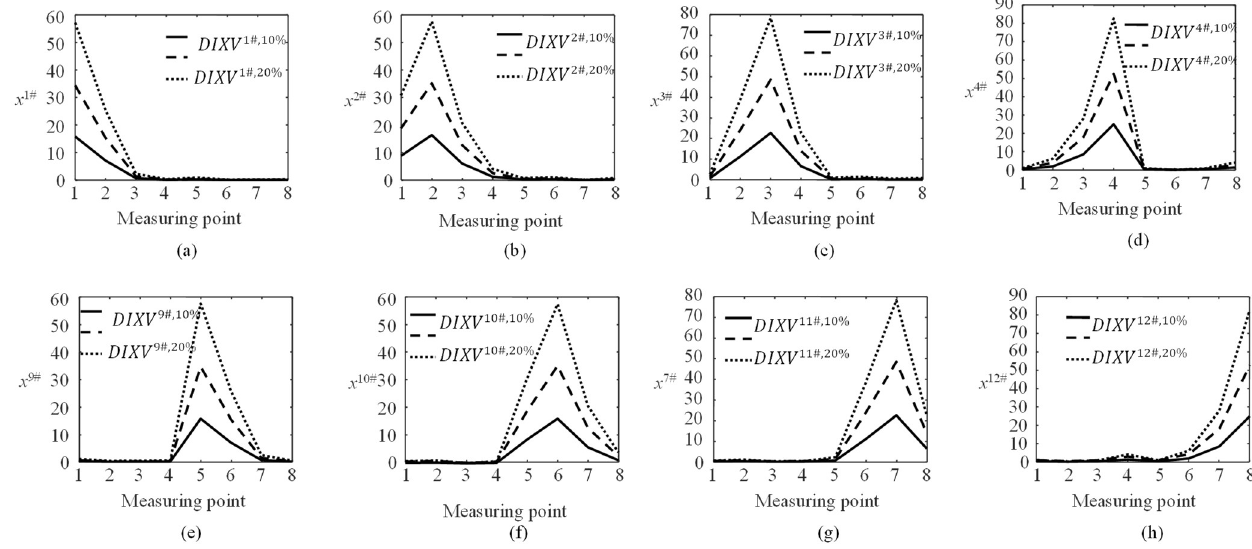
Figure 10. The poly lines of DIXV with 10%, 20%, and 30% in Cables 1#–4# and Cables 9#–12#. ( a ) Cable 1#; ( b ) Cable 2#; ( c ) Cable 3#; ( d ) Cable 4#; ( e ) Cable 9#; ( f ) Cable 10#; ( g ) Cable 11#; ( h ) Cable 12#.